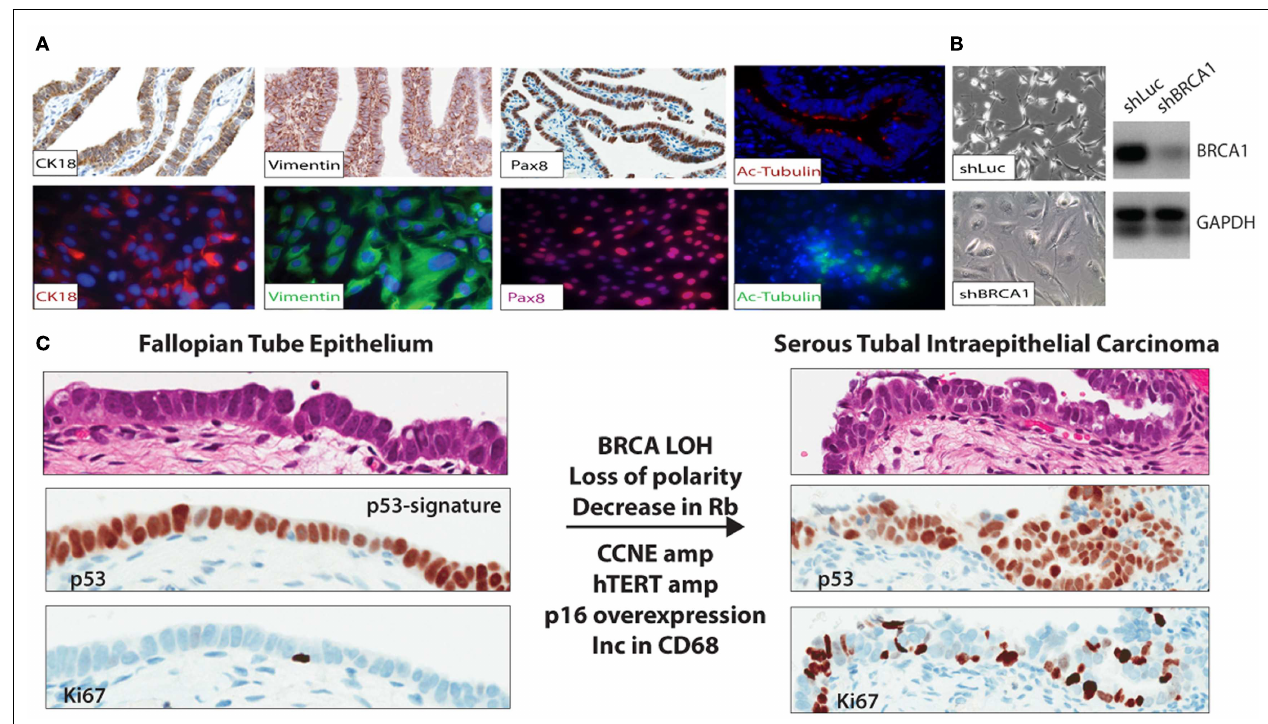
enlarged, and vacuolated. PCR confirmed knockdown. (C) In the p53 signature in the normal FTE, low proliferation, normal cell polarity, and over-expression of p53 are observed.Thus far, BRCA loss-of-heterozygosity (in mutation carriers), decrease in Rb, and increase in p16 (immunohistochemistry), CCNE1 amplification, and over-expression (FISH and immunohistochemistry); hTERT amplification (FISH), common in HGSC are also observed in the STIC